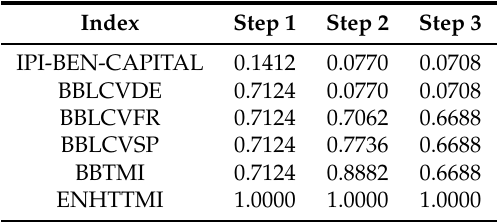
Table 13. Model Confidence Set Hierarchy Loss function is the squared error at the end of the sample for capital goods model comparison α = 0.05, number of bootstrap replications = 5000 and block length = 12. The null hypothesis is that the average performance of the model in the row is as small as the minimum average performance across the remaining models. The alternative is that the minimum average loss across the remaining models is smaller than the average performance of the model in the row.